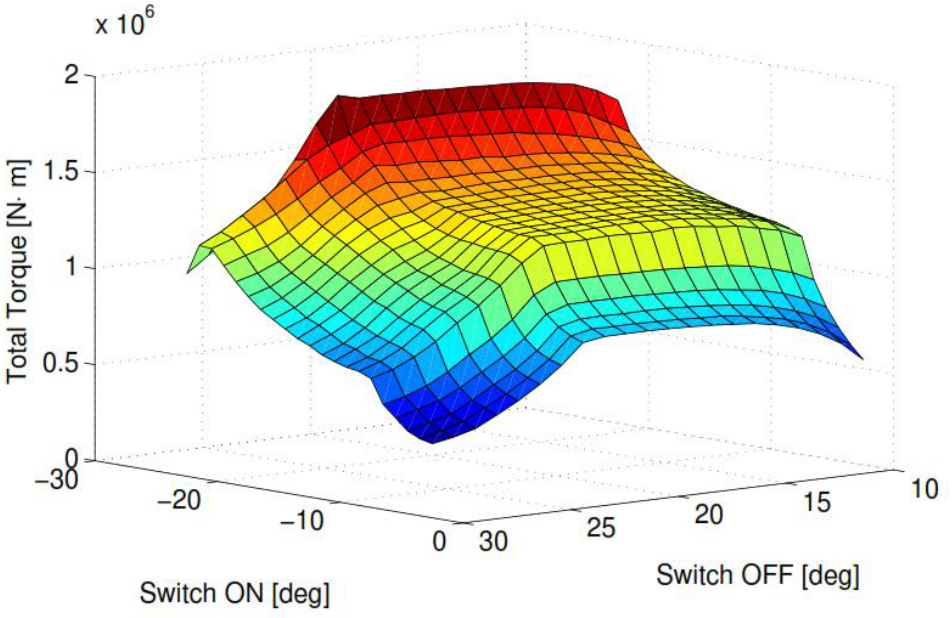
Figure 15. Switching-angle tuning